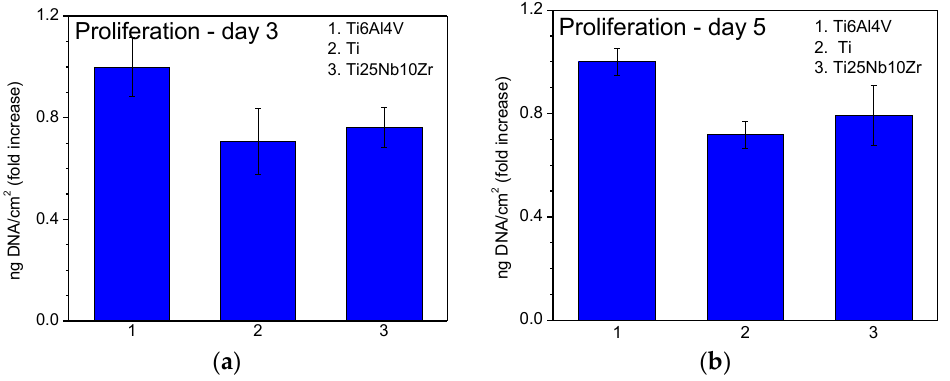
Figure 11. Cell proliferation of the samples measured after 3 ( a ) and 5 ( b ) days of culture. Metals 2017 , 7 , 86